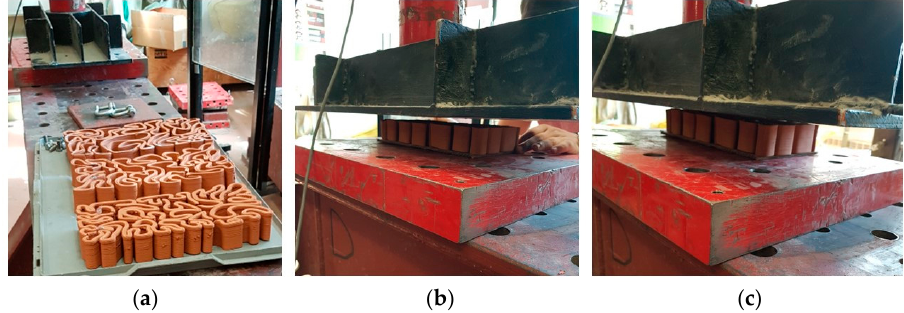
Figure 4. Compression Test. exhibiting the compression test for the 3D-printed biodigital clay bricks conducted by an oleo hydraulic actuator MTS of 250 kN range, and force was applied at 1 kN/s: ( a ) the linear models of (V1, V2, V3) families of the 3DPBDCB, ( b ) and ( c ) shows the adjustment of the bricks under the actuator. At the facilities of the CATMech-Litem research group (ESEIAAT School, UPC). (By authors).